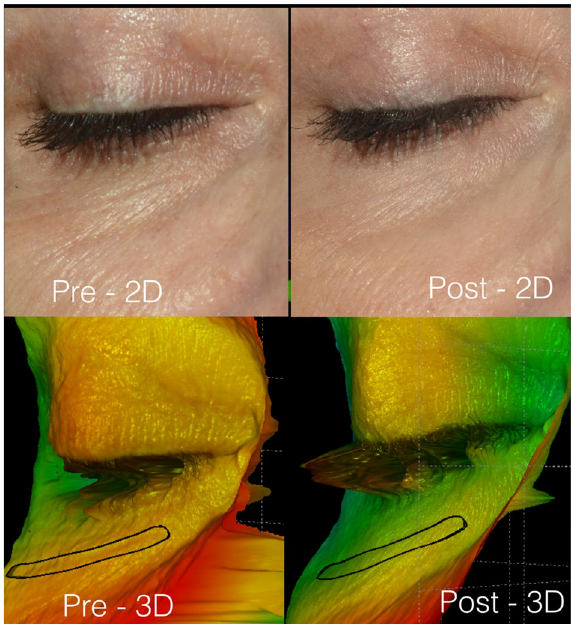
overestimate the wrinkle amelioration whereas the 3D SPM system quantified it as a mild